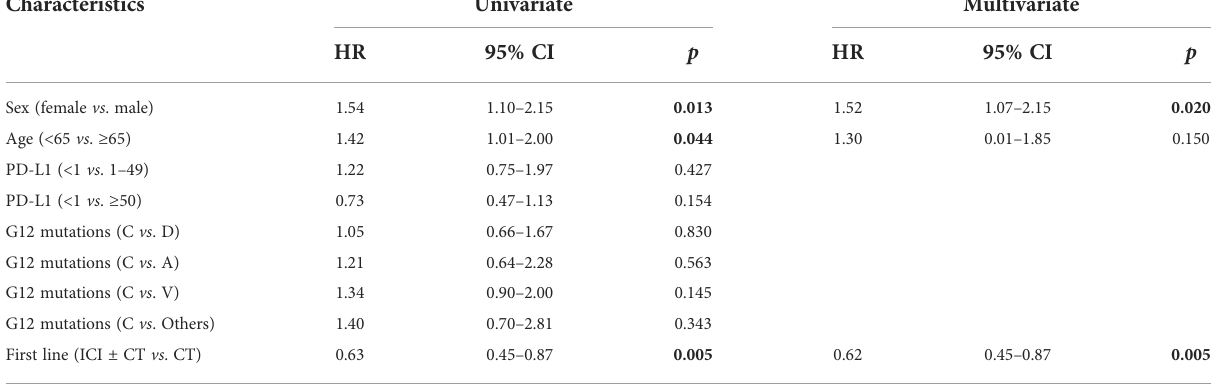
TABLE 2 Univariate and multivariate progression-free survival analysis. Characteristics